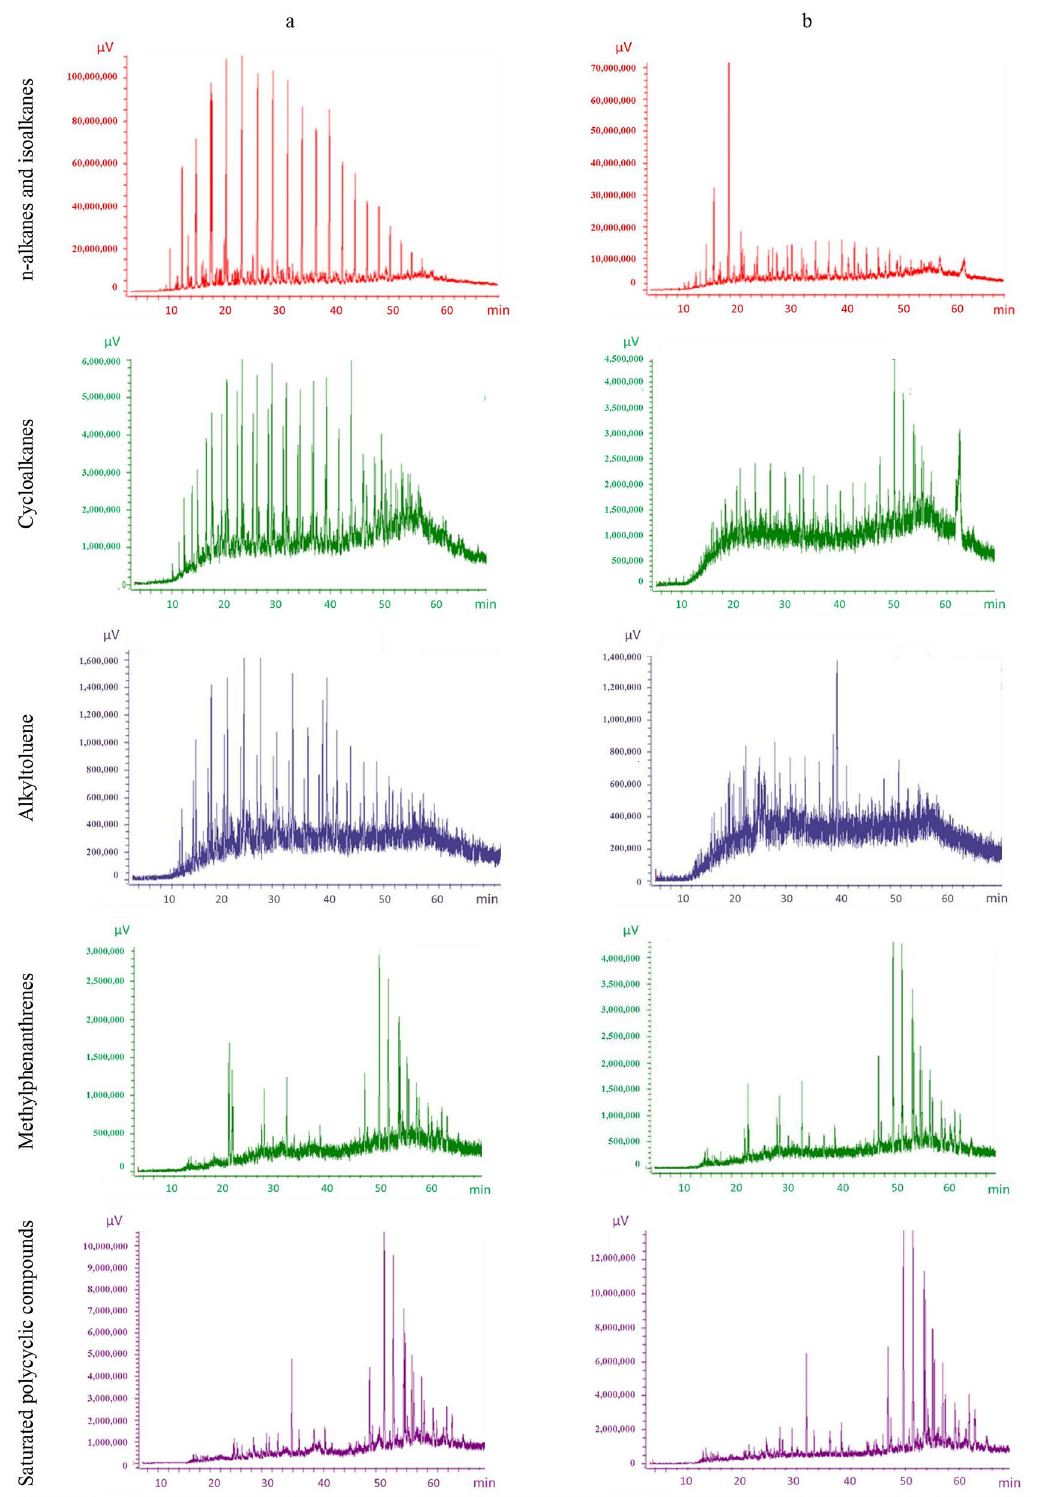
Figure 2. Composition of the different groups of hydrocarbons in the S soil sample with 6% crude oil at the beginning ( a ) and end of incubation ( b